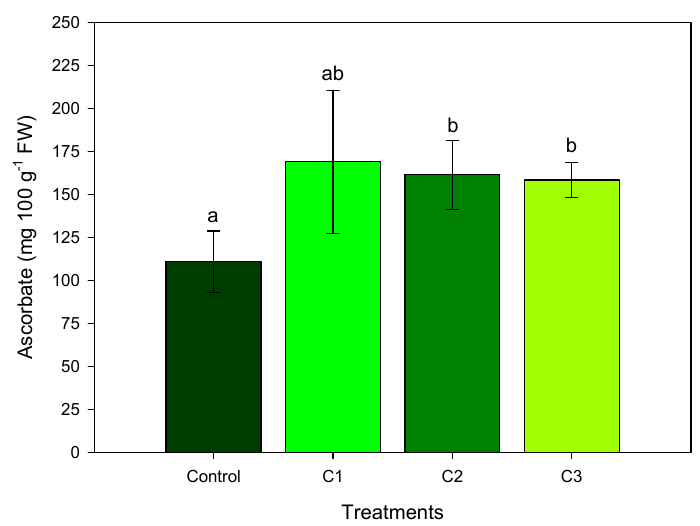
Figure 4. Ascorbate content in pepper fruits at the second harvest (127 days) of the Exp. No. 2. Data represent the mean of eight independent replicates and the same lower-case letter among treatments indicates that they are not statistically different according to one-way ANOVA with Tukey–Kramer post-hoc test at p < 0.05. Control, plants grown with full nutrient solution; C1, C2, and C3, plants grown with 8%, 17%, and 33% ( v / v ) compost, respectively, and supplemented with NO 3 − 14.92 mM. ROS present in plant cells can function as either signalling molecules or toxic by-products of the aerobic metabolism according to their cellular concentrations [20]. It is well documented that certain stress conditions can increase the ROS content such as pathogen infection, high and low temperature, drought and salt stress, heavy metal, atmospheric pollutants and physical and mechanical wounding, among others [19]. This being the case, antioxidants, enzymatic and non-enzymatic either play an important role modulating the levels of ROS in signalling issues or scavenging their deleterious potential when they are over-produced [19,20]. Nutrient deficiency also induces ROS signalling, especially during nitrogen, phosphorus and potassium starvation [44].